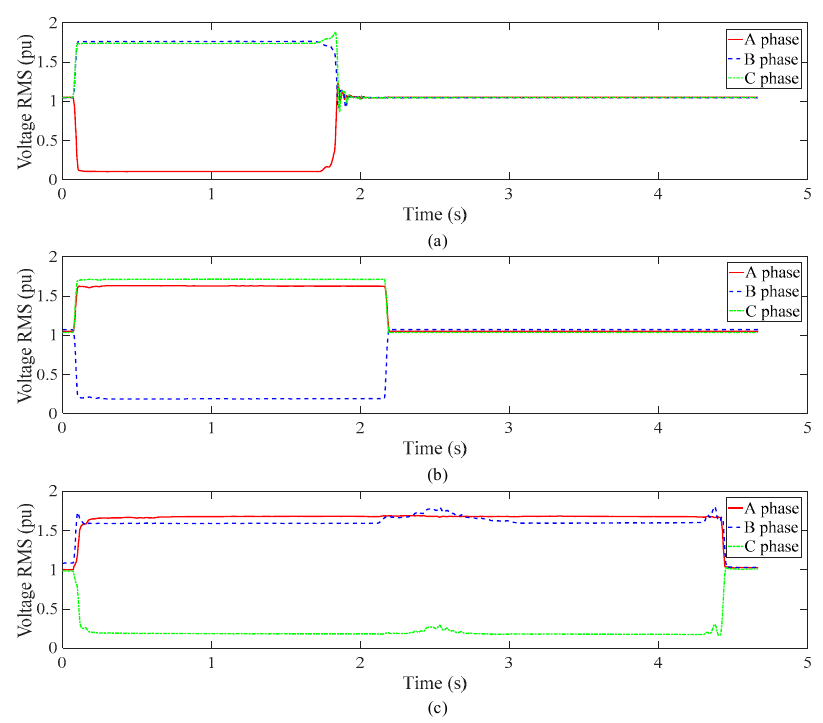
Figure 1. Typical waveforms of a single-phase short circuit. ( a ) Typical voltage root mean square (RMS) waveform of an A-phase short circuit; ( b ) typical voltage RMS waveform of a B-phase short circuit; ( c ) typical voltage RMS waveform of a C-phase short circuit.